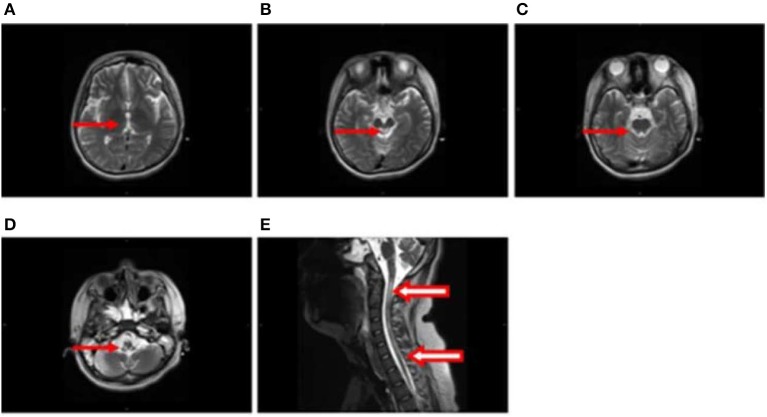
(A–E) Axial and sagittal T2-weighted MRI at 7 months following hospitalization revealed hyperintensities in the bilateral thalamus (arrow in A), tegmental area of the midbrain (arrow in B), pons (arrow in C), medulla (arrow in D), and the cervical and thoracic spinal cord (new lesions, hollow arrow in E). The previously identified lesions had decreased in size because of atrophy.